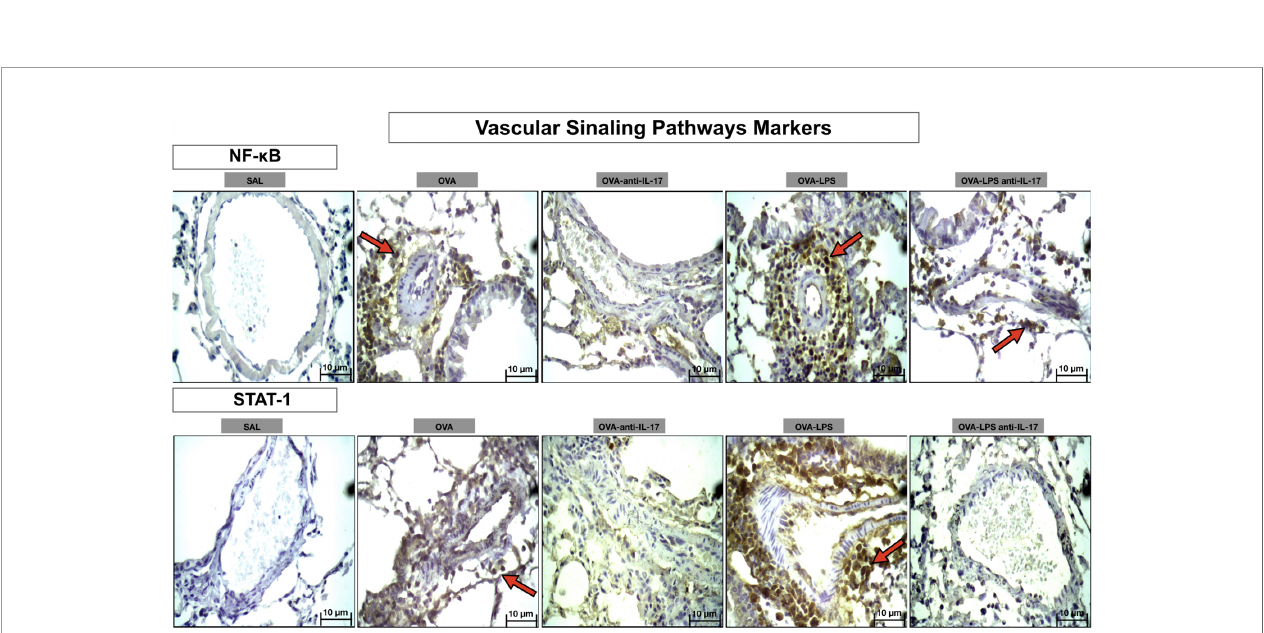
FIGURE 11 | Qualitative analysis of vascular signaling pathways. Photomicrographs showing the presence of in fl ammation around the pulmonary vessels. The slides were stained for NF-kB and STAT-1-expressing positive cells. The experimental groups include SAL, OVA, OVA-anti-IL-17, OVA – LPS, and OVA – LPS-anti-IL-17. The red arrows indicate the positive cells for NF-kB and